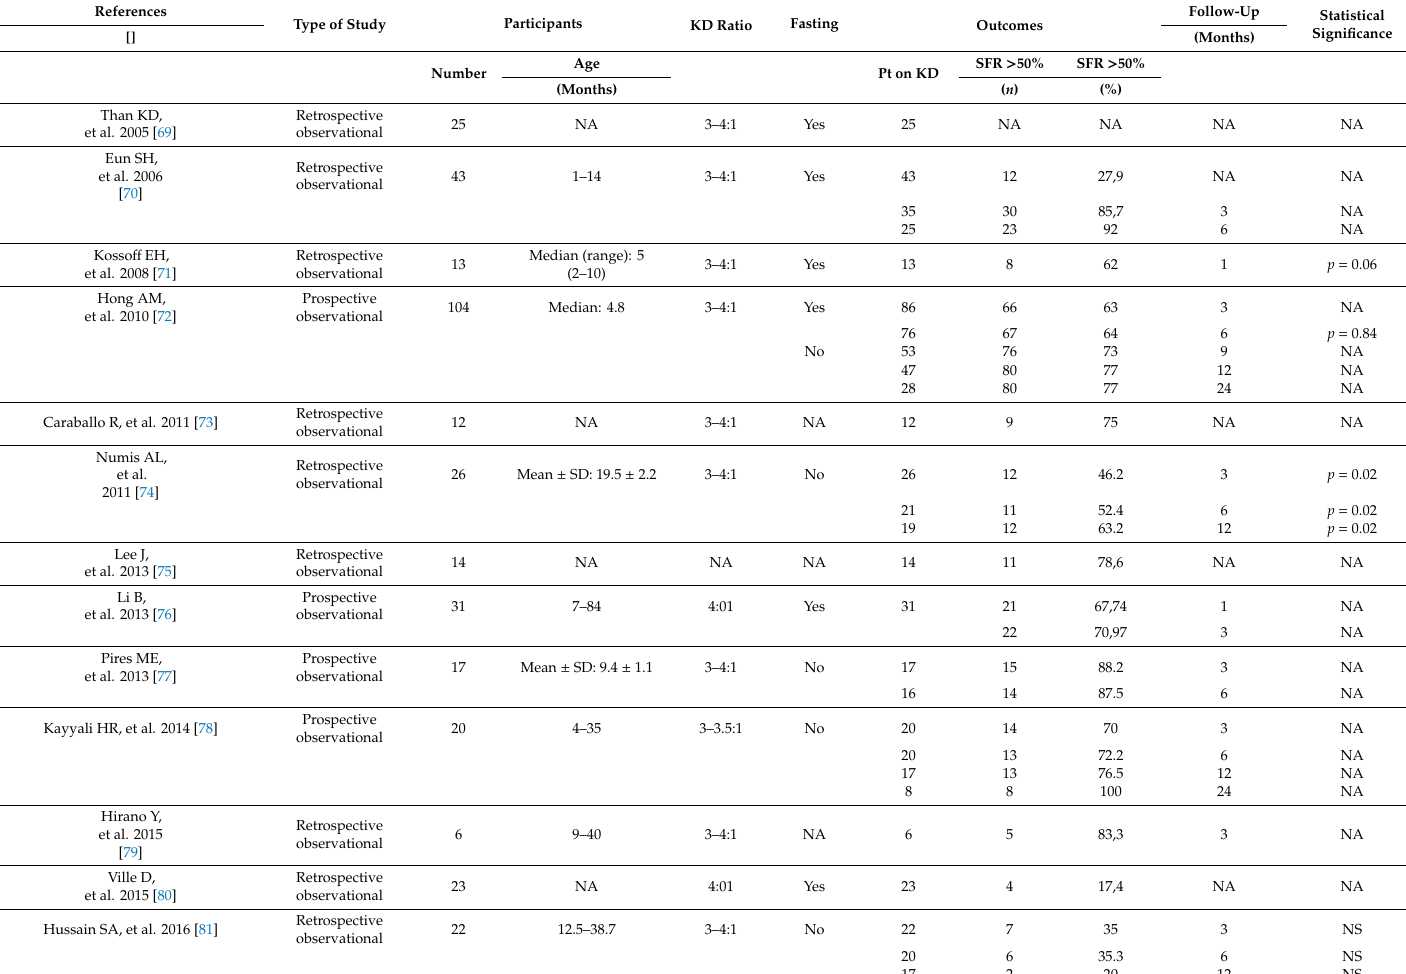
Table 4. Most relevant articles on the use of KD (associated with AED therapy) in infantile